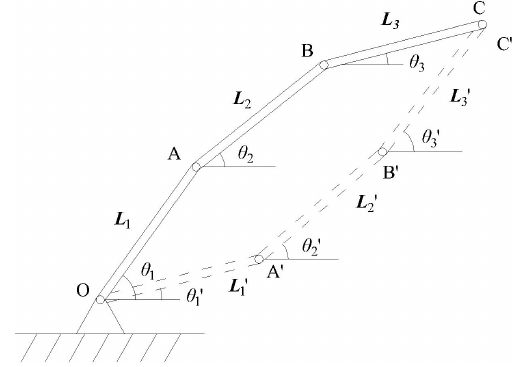
Figure 1. Schematic of a 3-DOF manipulator.